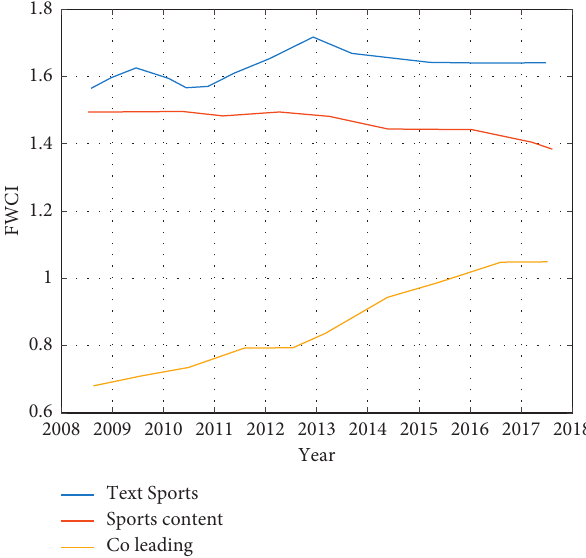
Figure 13: Trend of the average FWCI for the whole field of sport and collaborative papers in both countries.